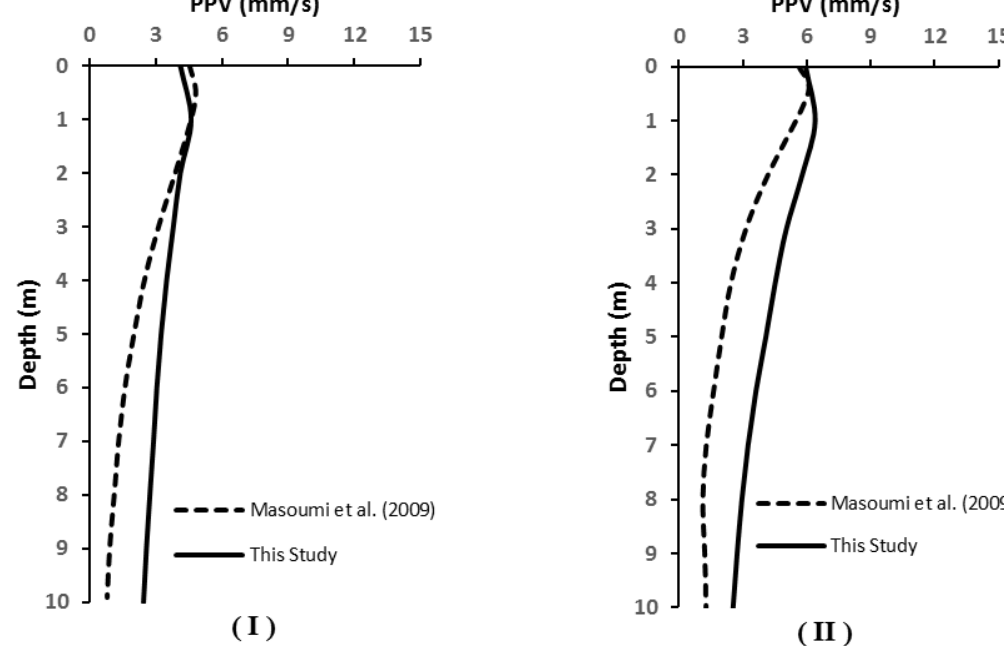
Fig. 6. Comparison of PPV values of this study with numerical results of Masoumi et al. (2009) for points located at various depths in radial distance of 20 m from the pile axis when impact on pile is applied at penetration depth of: (I)